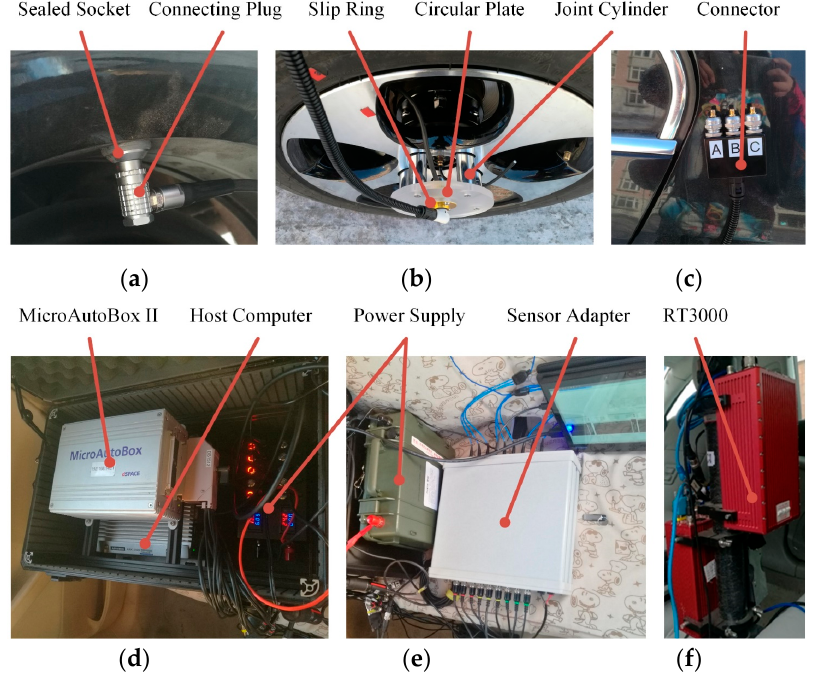
Figure 3. Test setup and equipment: ( a ) Connector on the rim well; ( b ) slip ring module; ( c ) connector on the vehicle body; ( d ) data-collection system; ( e ) battery and adapter; ( f ) combined inertial and global navigation satellite system (GNSS) system.